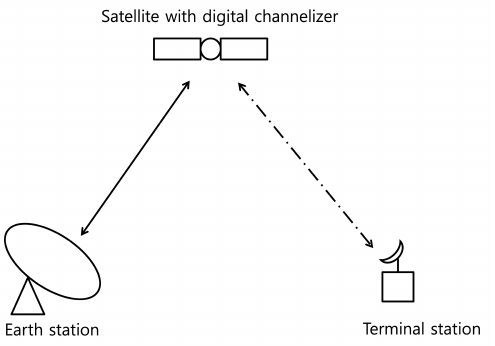
Figure 2. Satellite communication channel with Earth and terminal stations, and satellite with a digital channelizer.